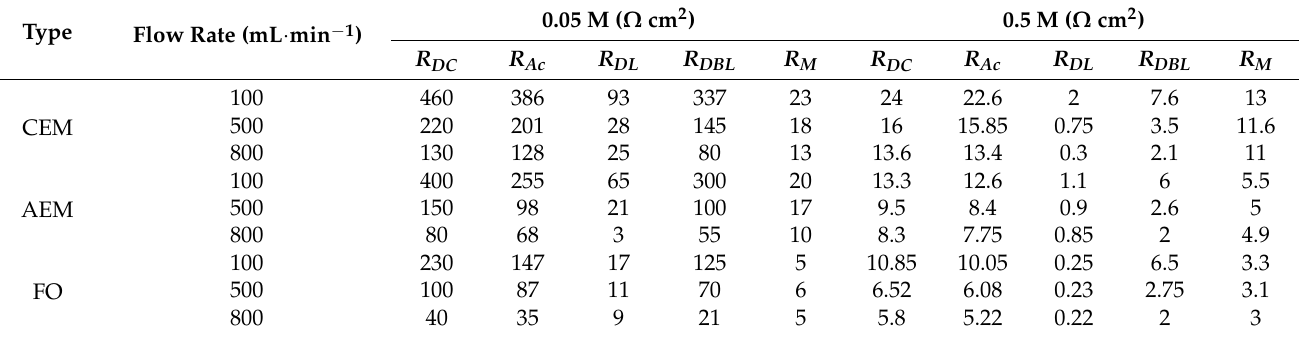
Table 2. Comparison of impedance values measured by DC and AC impedance